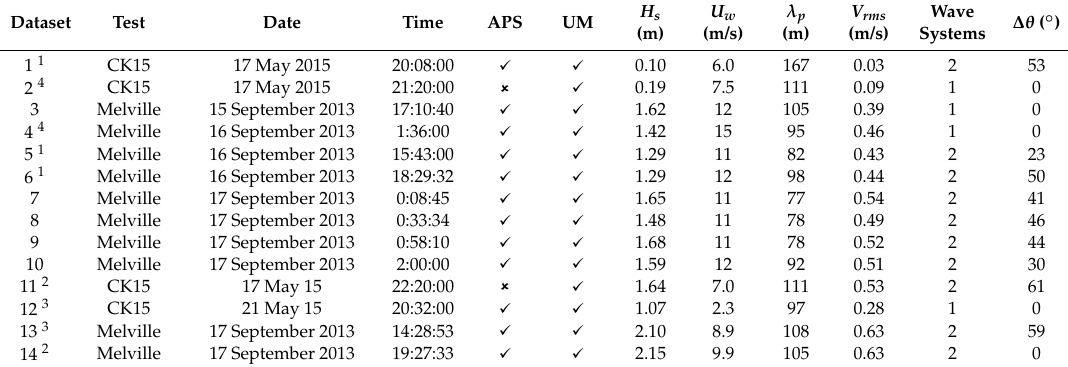
Melville Melville 17 September 2013 14:28:53 Highest U w for respective test.